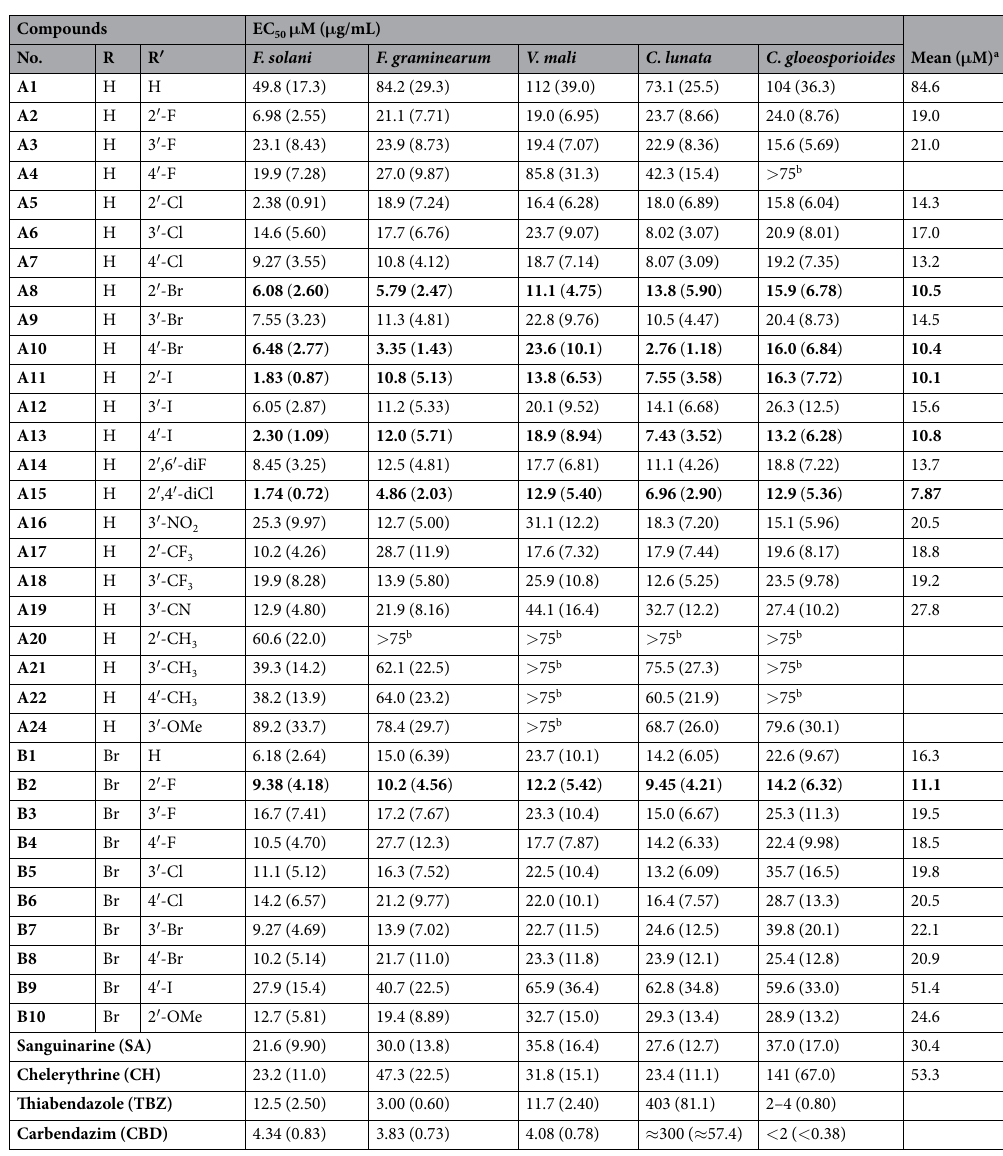
Table 3. EC 50 values of compounds A and B against five fungi. a Mean: the average EC 50 values of the same compound against the five fungi. b Estimated EC 50 values based on the results in Tables 1 and